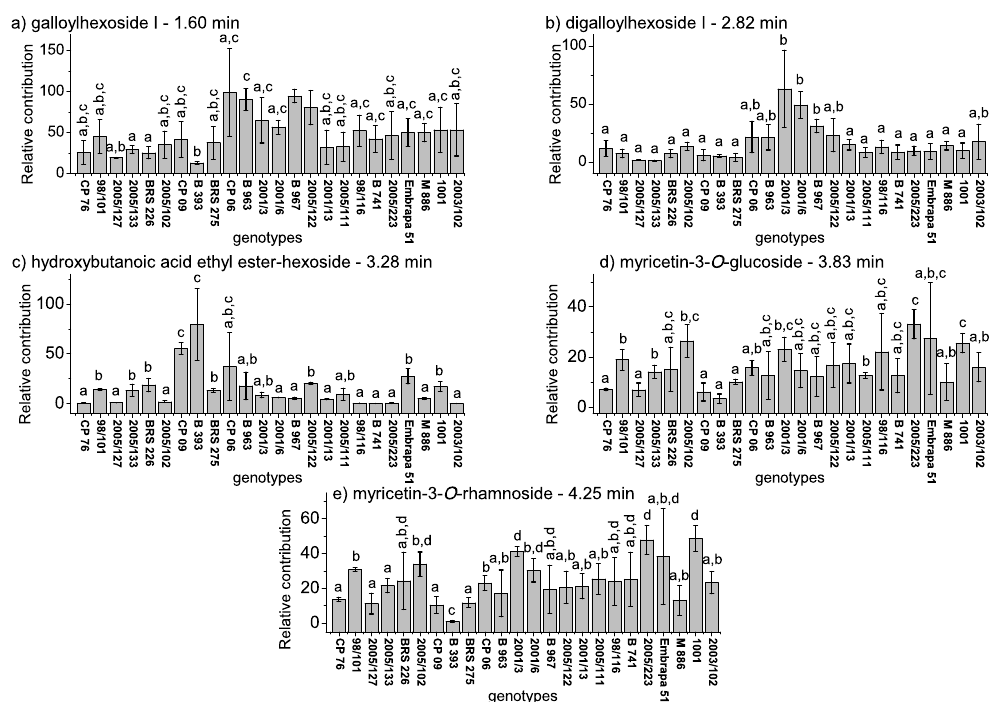
Figure 4. Relative contributions of the isotopic forms in chromatograms (UPLC-HRMS) for the compounds at retention times of 1.60, 2.82, 3.23, 3.82, and 4.25 min.